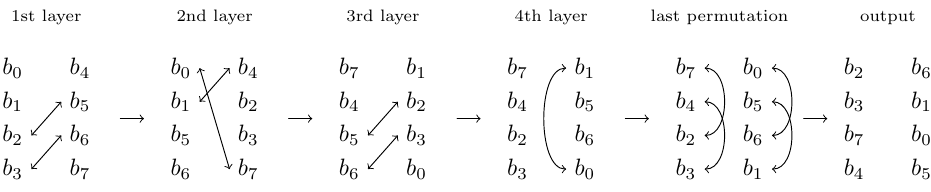
Figure 12: The bit permutations during the nibble-wise S-box